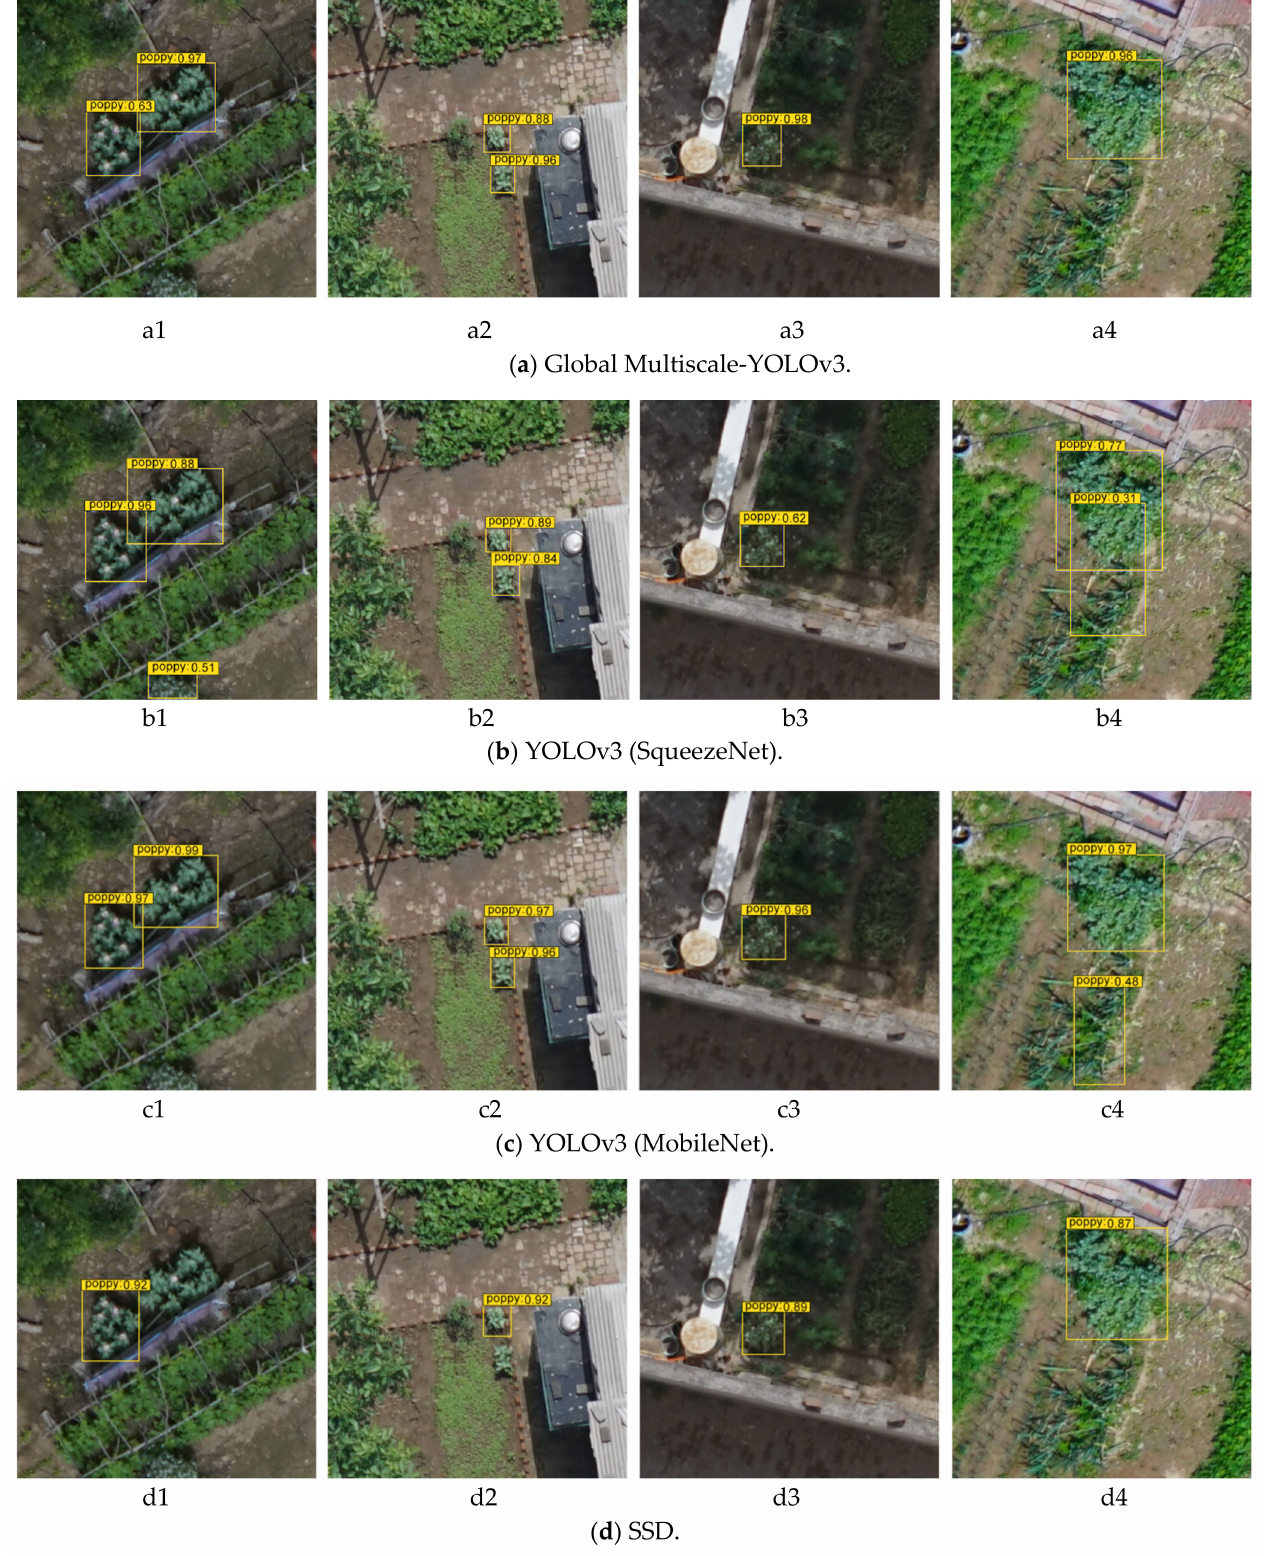
Figure 12. Detection results of different detection